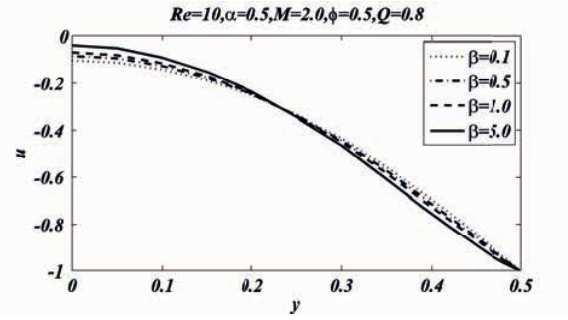
Fig. 5: Longitudinal velocity distribution for different values of β .